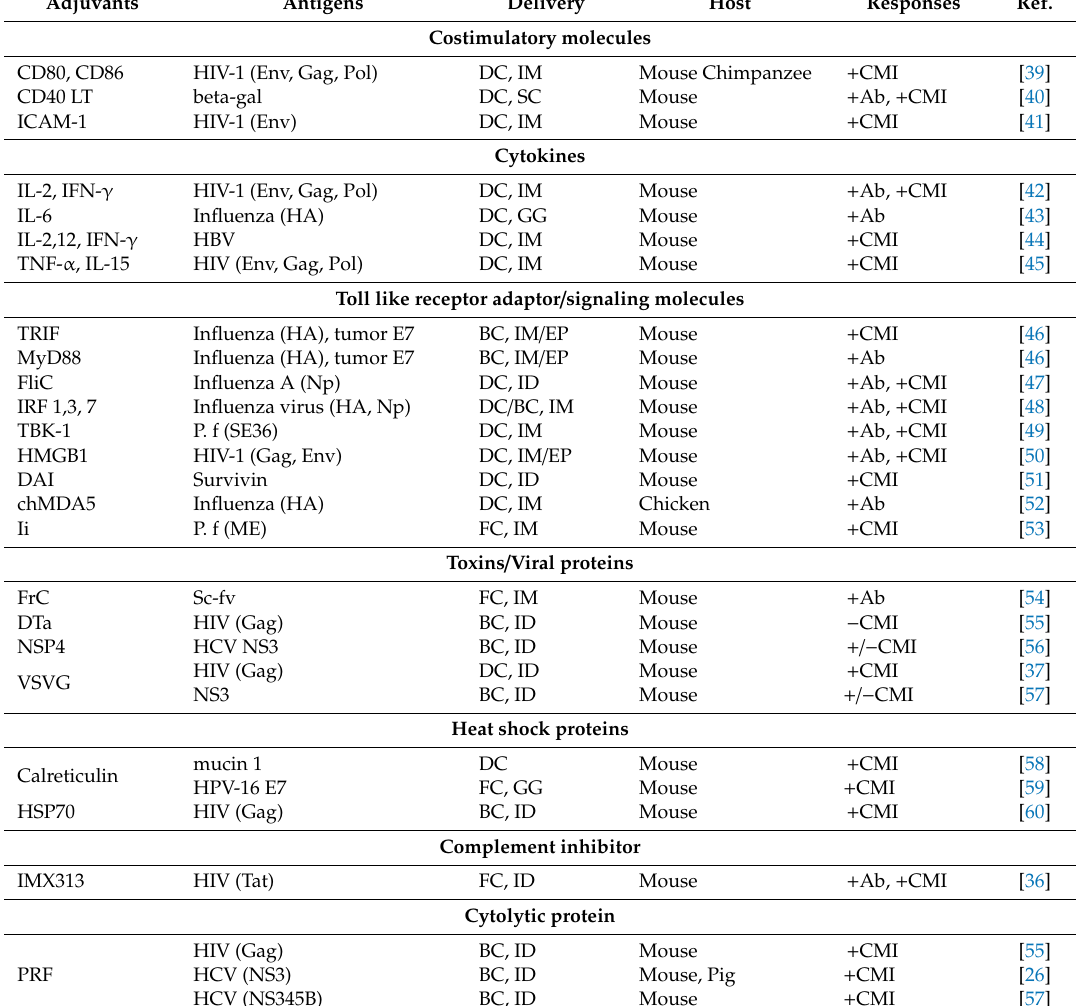
Table 1. Molecular adjuvants and immunogenicity of DNA vaccines in animals. Adjuvants Antigens Delivery Host Responses